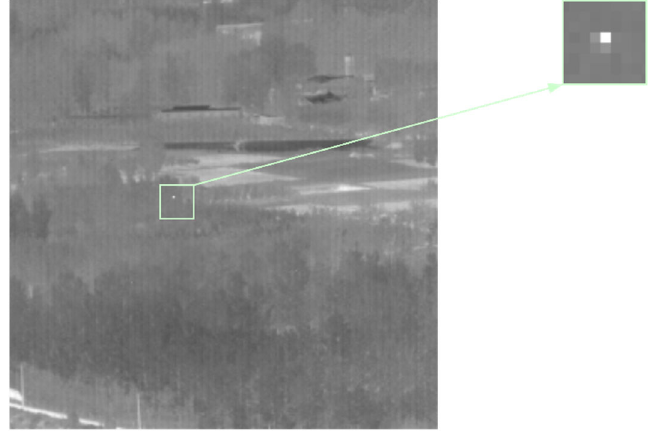
Figure 5. The arrow points to a magnified image of the small target, from which it can be seen that the center point of the small target is not easily defined.